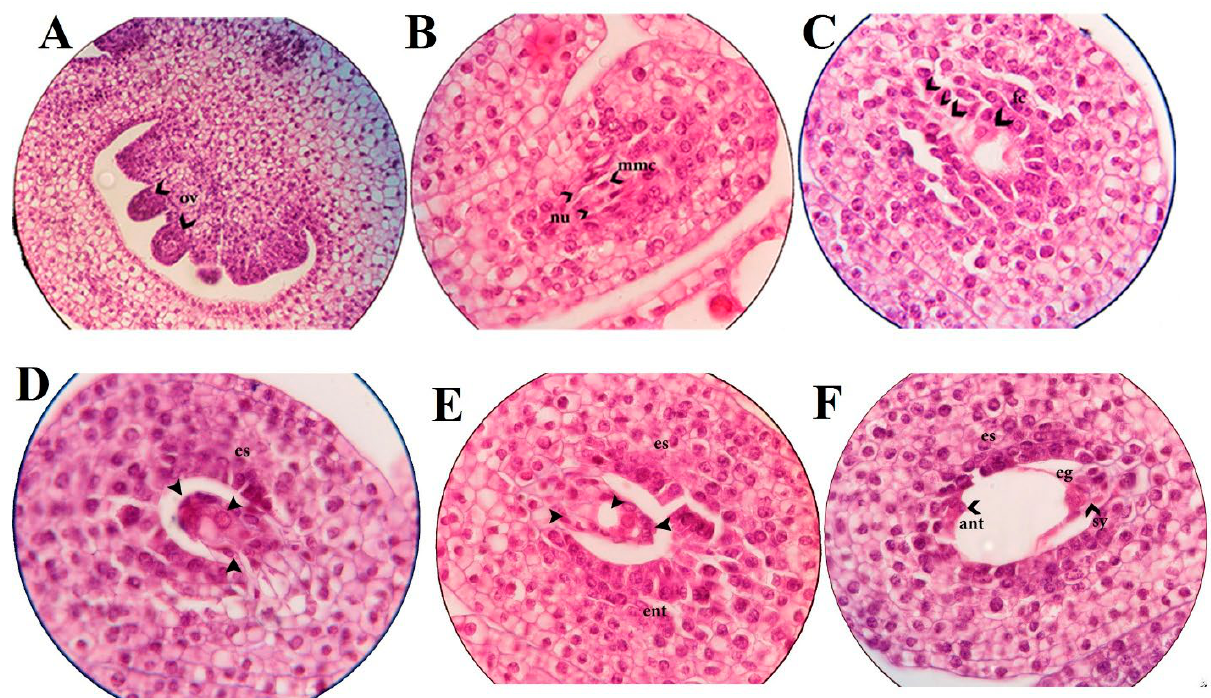
Figure 6. (A)Section of a single locule of ovary; (B) Megaspore mother cell (mmc) beneath the apical epidermis of the nucellus; (C) End of the mmc second meiosis and linear arrangement of the megaspores; (D) Eight-nucleate immature embryo sac; (E) Eight-nucleate immature embryo sac; (F) Eight-nucleate and seven-celled mature embryo sac (ant – antipodal; eg – egg cell; ent – endothelium; es – embryo sac; fc – functional megaspore; mmc – megaspore mother cell; nu – nucellus; ov – ovule; sy – synergid).